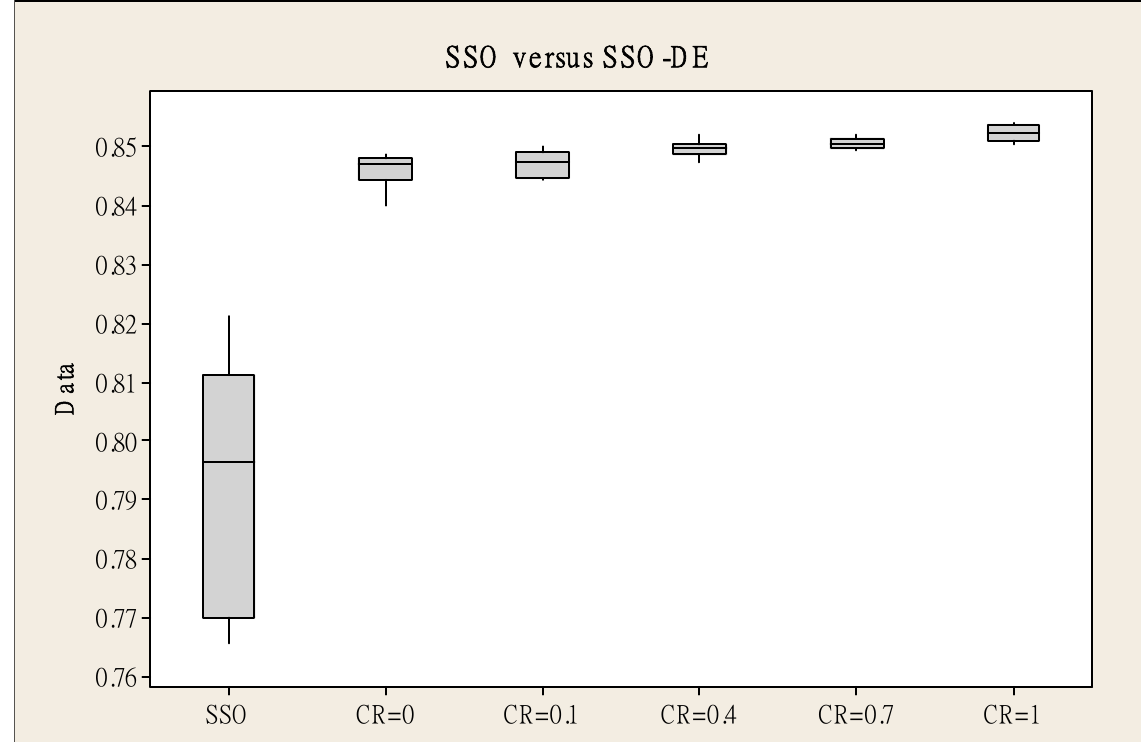
Figure 9. Box and whisker diagram of SSO and SSO-DE for winter.